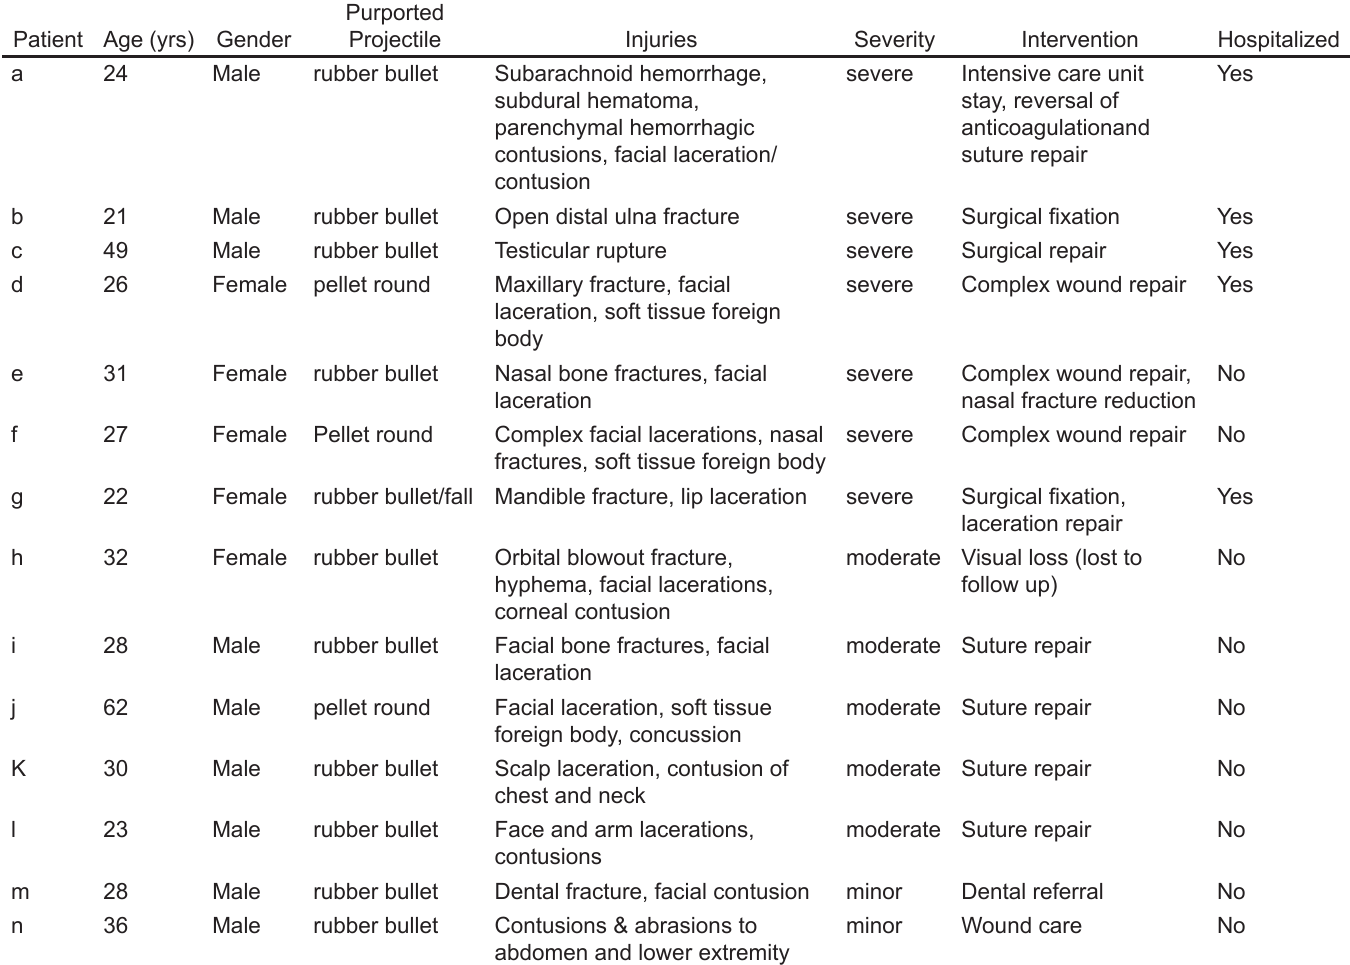
Table. Patient characteristics, injuries, and disposition from kinetic impact projectiles. Patient Age (yrs)